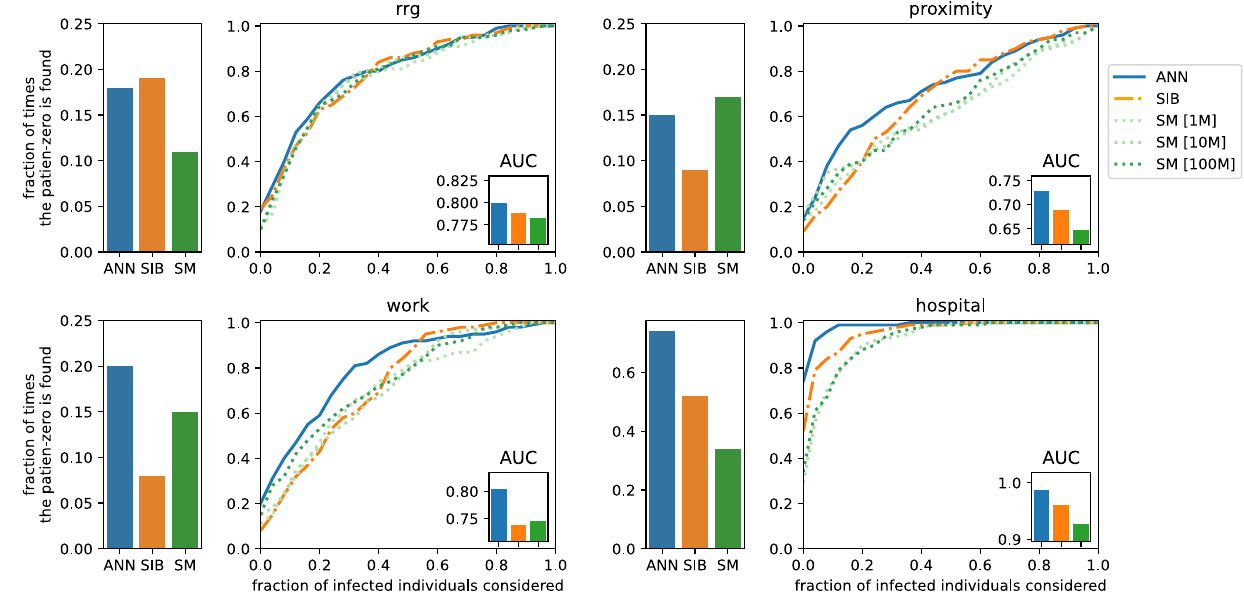
Figure 4. Results of the patient zero problem. The left bar plots, for each case, represent the fraction of times, in 100 different epidemic cascades, the patient zero is correctly identified at the first position of the ranking given by the algorithms. The right plots show the fraction of times the patient-zero is found (in 100 different epidemic cascades) in a fraction of infected or recovered individuals ranked according to the probability to be patient zero given by the three algorithms ANN, SIB, and SM (the values of the area under the curve [AUC] are shown in the insets). For the rrg we consider the following epidemic parameters (cid:31) = 0.04 and µ = 0.02 and for proximity (cid:31) = 0.03, µ = 0.02 . The epidemic parameters for ( work ) and ( hospital ) are respectively γ = 10 − 3 , µ = 0.02 and γ = 2 · 10 − 4 , µ = 0.02